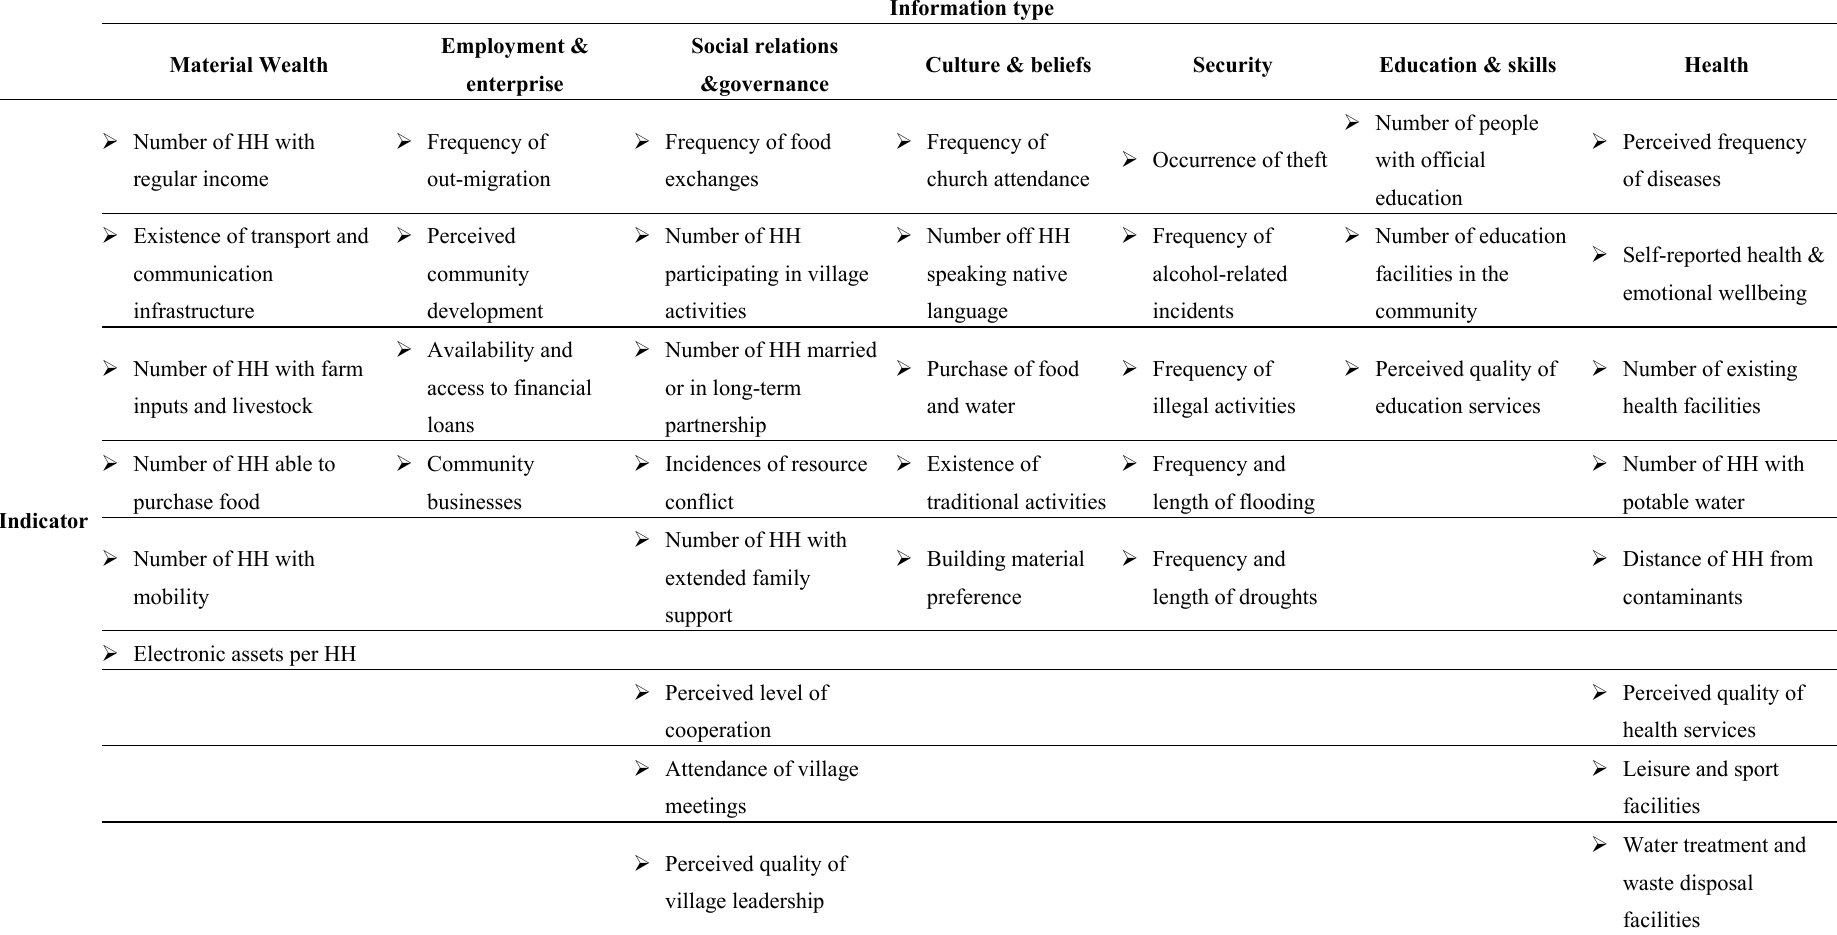
Table 2. Community-defined wellbeing